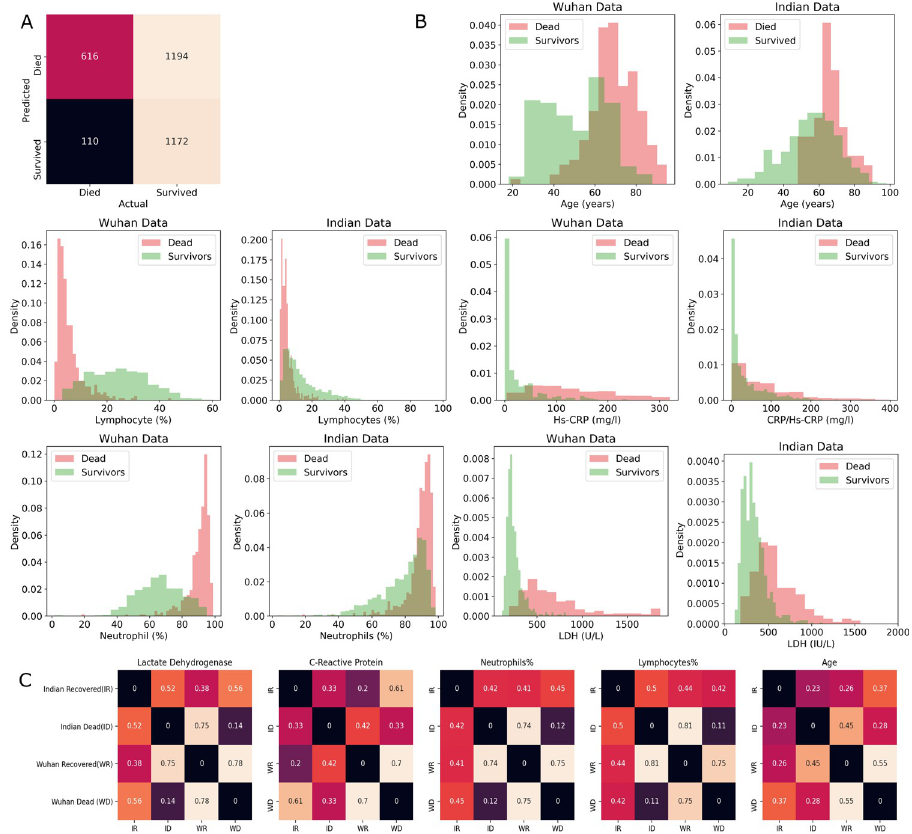
Fig 3. (A) Confusion matrix of neural net trained on Wuhan data and tested on Indian data. This was done by comparing actual and predicted mortality of patients in the dataset. (B) Comparison of the normalized histogram plots of important features useful for predicting mortality from Wuhan and Indian Cohorts. It shows the comparative distribution of clinical parameters between death and survival cases. (C) Pair-wise distances between distributions of important features across the Indian vs. Wuhan survived and dead classes. Distance values were calculated through Kolmogorov–Smirnov test.